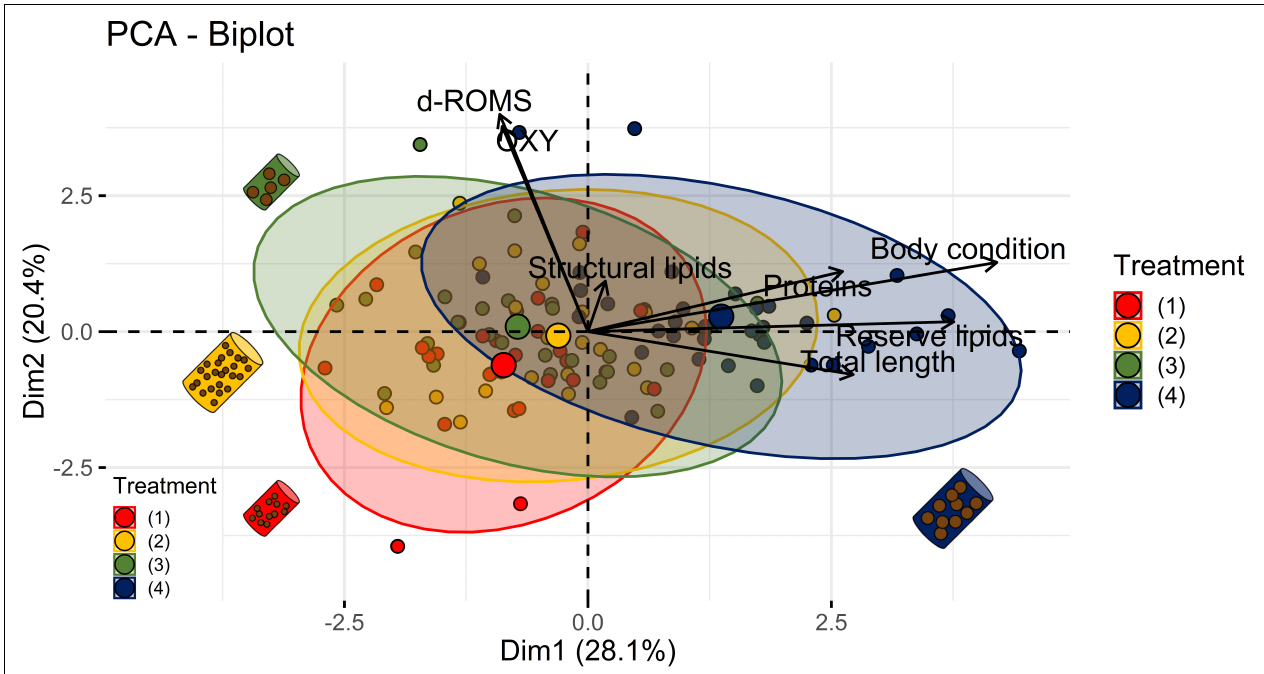
FIGURE 5 | Biplot of the PCA built using body condition, total length, reserve and structural lipids and proteins contents, d-ROMs and OXY as explanatory variables. Ellipses correspond to 95% confidence level for each treatment. The large circles represent the barycenter of the individuals for a given treatment.